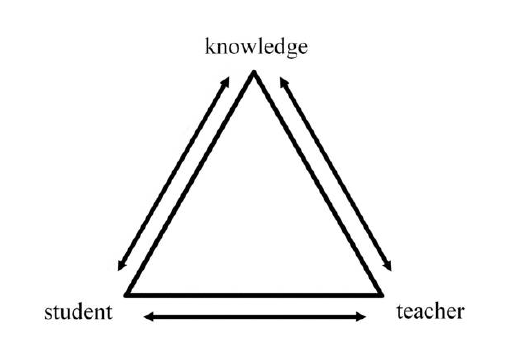
Figure 2. Interactive Triangle ofthe two-way relationship knowledge-teacher- student.